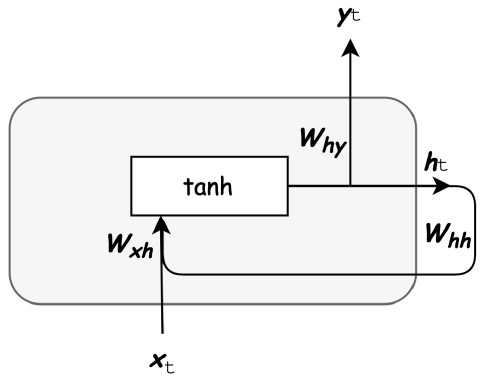
Figure 1. Recurrent Neural Network